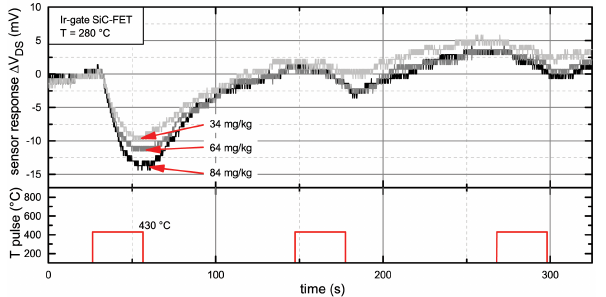
Figure 12. Top: difference signal of an Ir-gate FET at 280 ◦ C to different concentration of ammonia (34, 64, 84mgkg − 1 ). Bottom: heating pulses up to 430 ◦